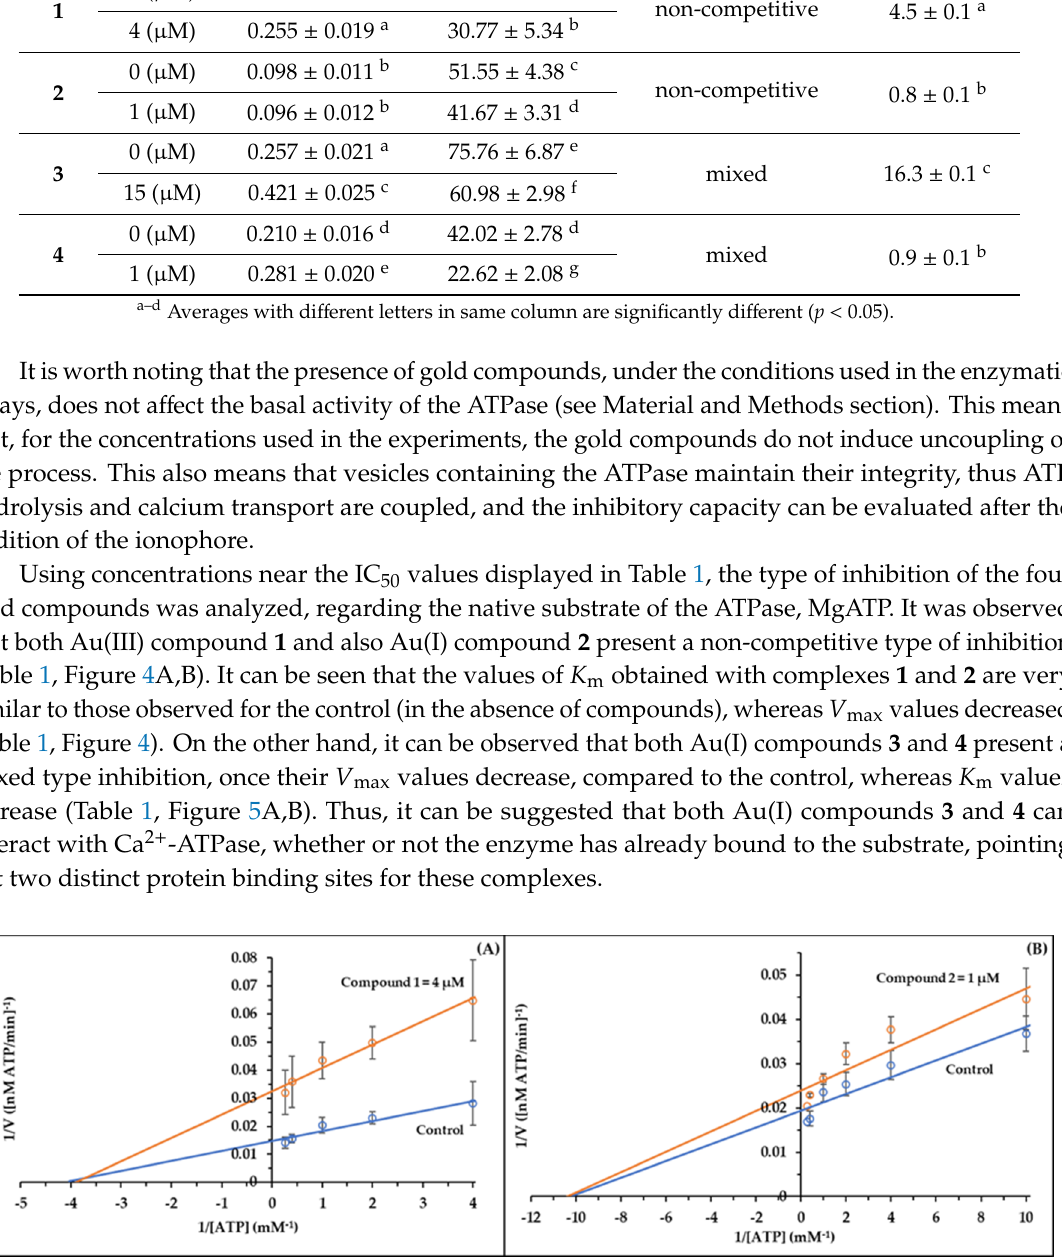
Figure 4. Lineweaver-Burk plots of Ca 2+ -ATPase activity in the absence (blue) and in the presence (orange) of 1 or 4 µM of the gold compounds. ( A ) Gold compound 1 ; ( B ) Gold compound 2 . The plots were used for determining the type of enzyme inhibition. The gold complexes presented a non-competitive type of inhibition. Data are plotted as means ± SD. The results shown are the average of triplicate experiments, carried out in distinct preparations.